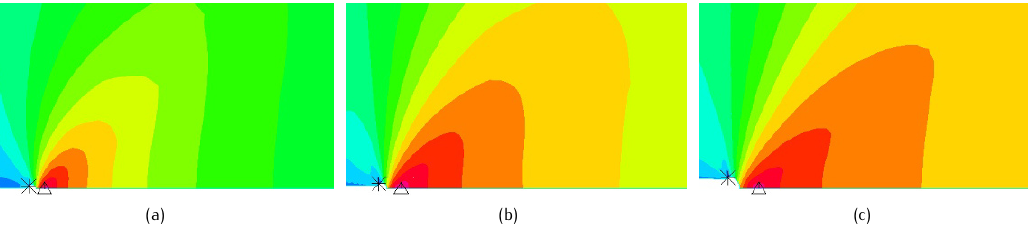
Figure 10. The influence of the external load on physical location of the maximum opening stress near crack tip for CC(T) specimen – σ 500 MPa, n = 10 , a/W = 0 . 50 , alongwiththeselectedlocationofmaximumopeningstressbytriangle: (a) P/P 0 = 0 . 4 , σ max /σ 0 = 3 . 07 , r max = 0 . 025 mm, ψ = 3 . 09 ; (b) P/P r max = 0 . 055 mm, ψ = 0 .